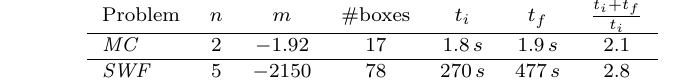
Table III. Formal Bounds Computation Results for Semialgebraic Relaxations of Global Opti- mization